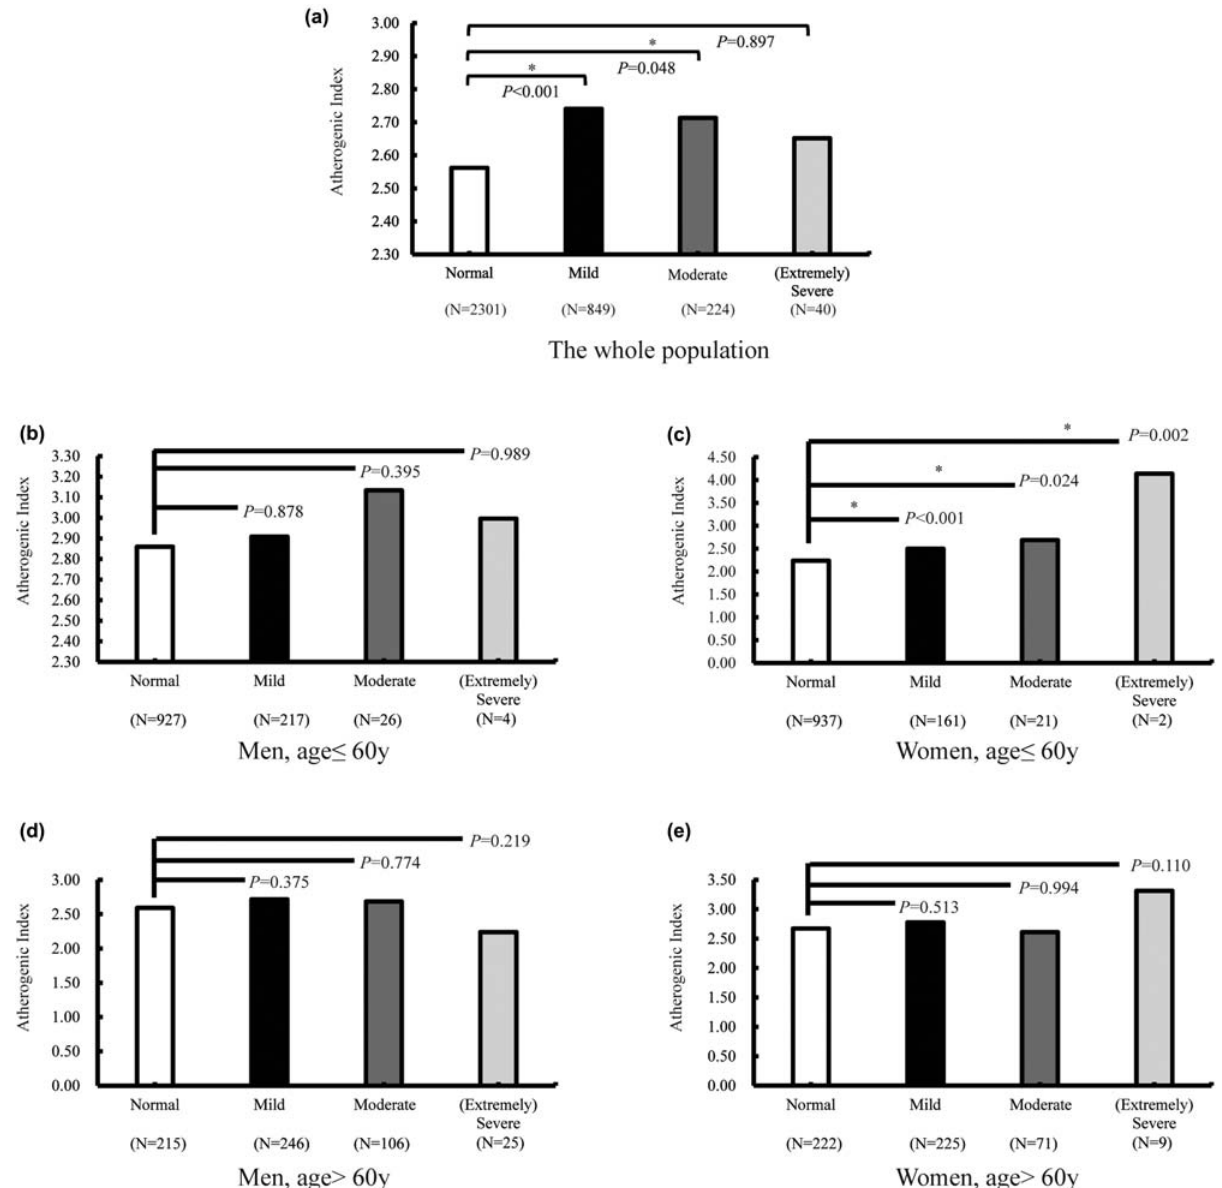
Figure 2: AI of di ff erent subgroups ( a: the whole population; b: men, age ≤ 60 years; c: women, age ≤ 60 years; d: men, age > 60 years and e: women, age > 60 years ) . The values corresponding to the ordinate unit length of each sub fi gure are di ff